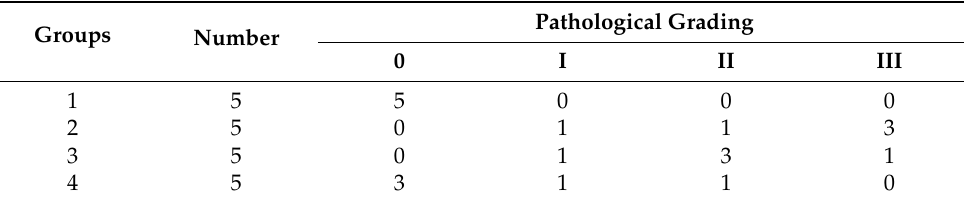
Figure 5. Histopathological features of liver in lead-acetate-induced anemic rats ( a – c ) treated with 27 ppm/day iron oxide nanoparticles ( d , e ) prepared chemically or ( f ) green biosynthesized with Petroselinum crispum leaf extract for 6 weeks. ( a ) Congestion of the portal veins with mild hyperplasia of the biliary epithelium (arrow). ( b ) Focal area of lytic necrosis characterized by loss of hepatocytes and replaced by aggregates of mononuclear leukocytes (arrow). ( c ) Apoptotic bodies in some degenerated hepatocytes (arrow, × 1000). ( d ) Degenerative changes of hepatocytes in combination with fibrous connective tissue proliferation around the bile duct (arrow). ( e ) Portal areas were mildly expanded by aggregates of mononuclear inflammatory cells—mainly lymphocytes and macrophages—in association with mild hyperplasia of the lining epithelium of the bile duct. ( f ) Improvement in the hepatocellular architecture with more regular and less altered hepatocytes. Table 4. Effect of chemical and natural iron oxide nanoparticles on the pathological grading of lead toxicity in renal tissues of different treated